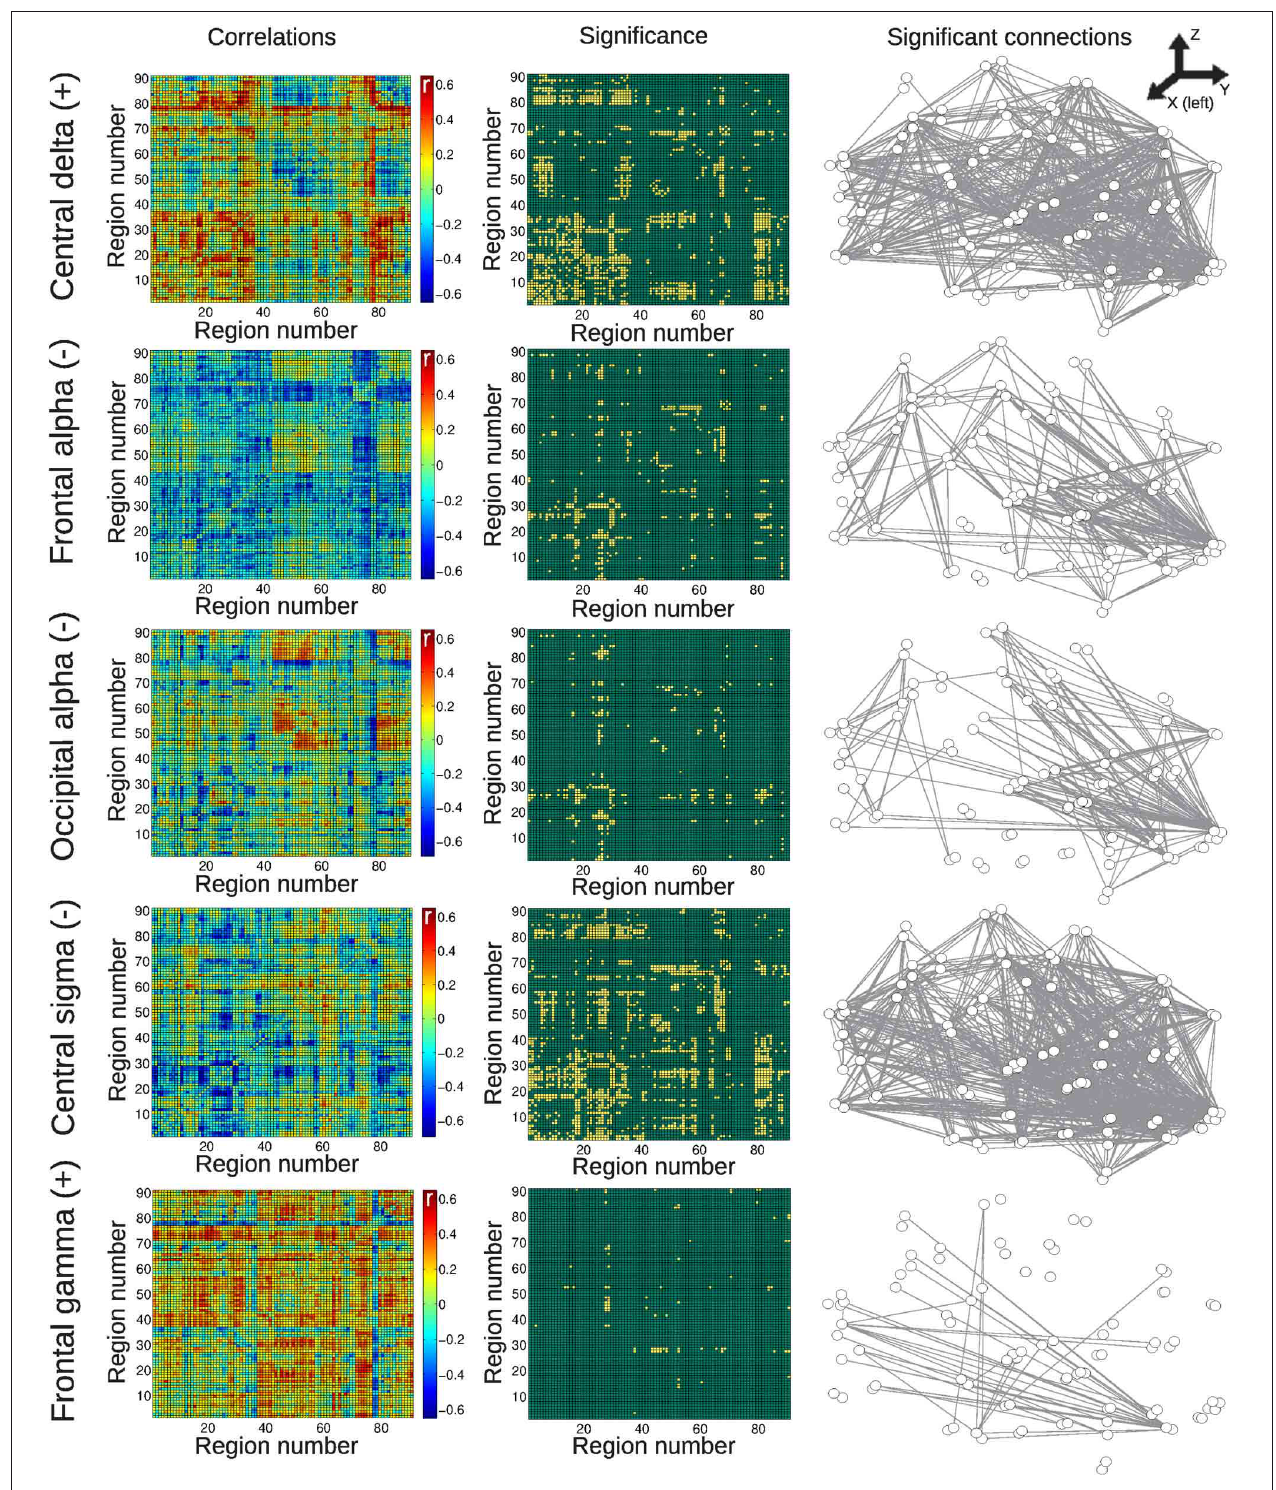
FIGURE 5 | Matrices of average correlation (left), significant correlations (center, significant correlations in yellow), and networks in anatomical space (left: posterior side, right: anterior side) with links representing significant correlations (right). Correlations are between temporal changes in BOLD functional connectivity and changes in EEG